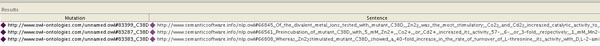
Query Result Example output from the query shown in Figure 8, listing all mutations that increased the protein property “activity”.